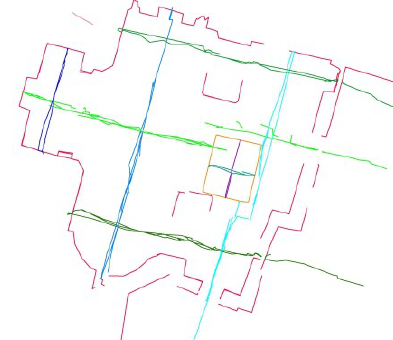
Figure 3. Measured sections using